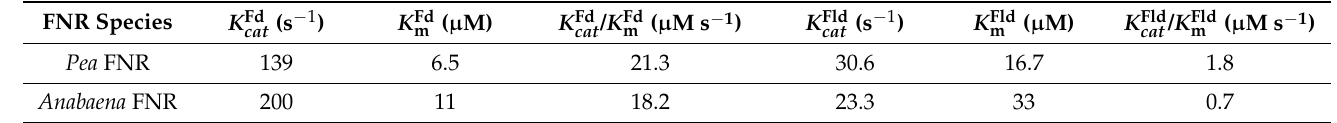
Table 2. Kinetic parameter of Pea and Anabaena FNR in NADPH-dependent cytochrome c reductase